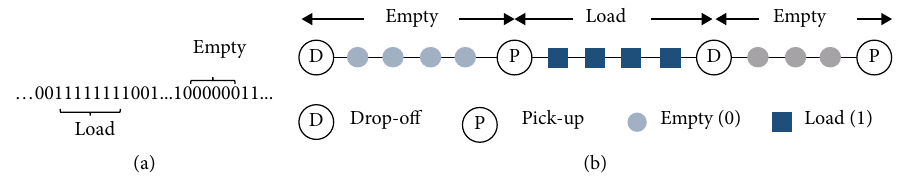
Figure 1: Taxi GPS trajectory (a) sequence of GPS trajectory (b) identification of pick-up and drop-off